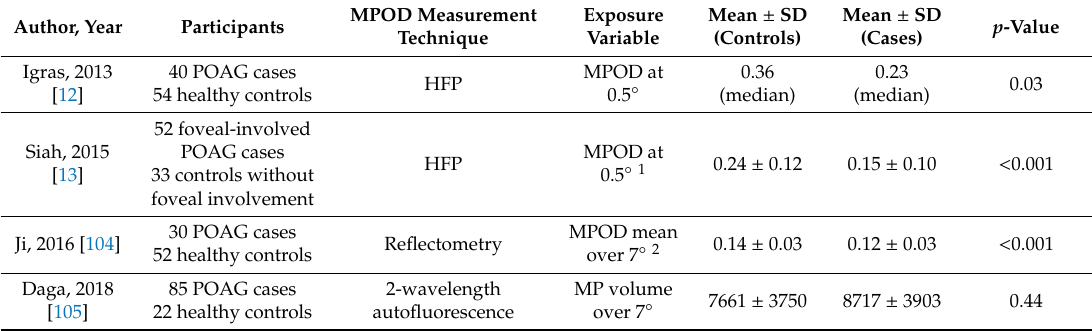
Table 2. Summary of cross-sectional studies of macular pigment optical density (MPOD) and primary open-angle